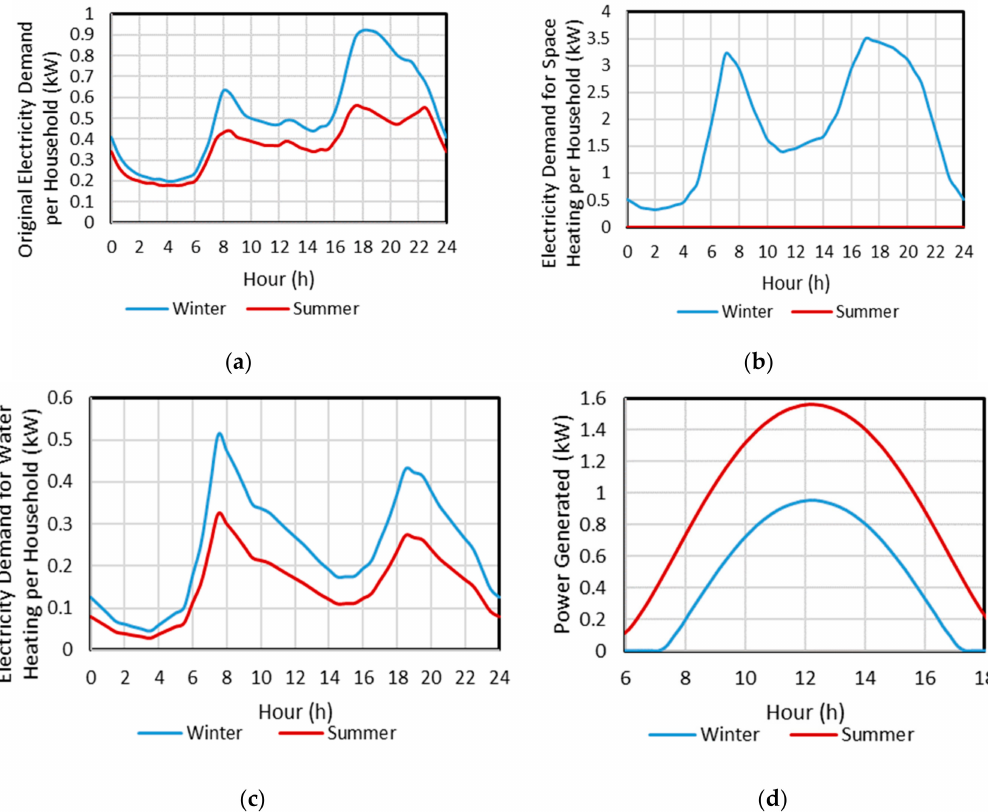
Figure 4. ( a ) Original electricity demand before including the smart appliances, ( b ) space heating demand, ( c ) water heating demand, and ( d ) power generated by 3 kWp PV array for an average household located at the study